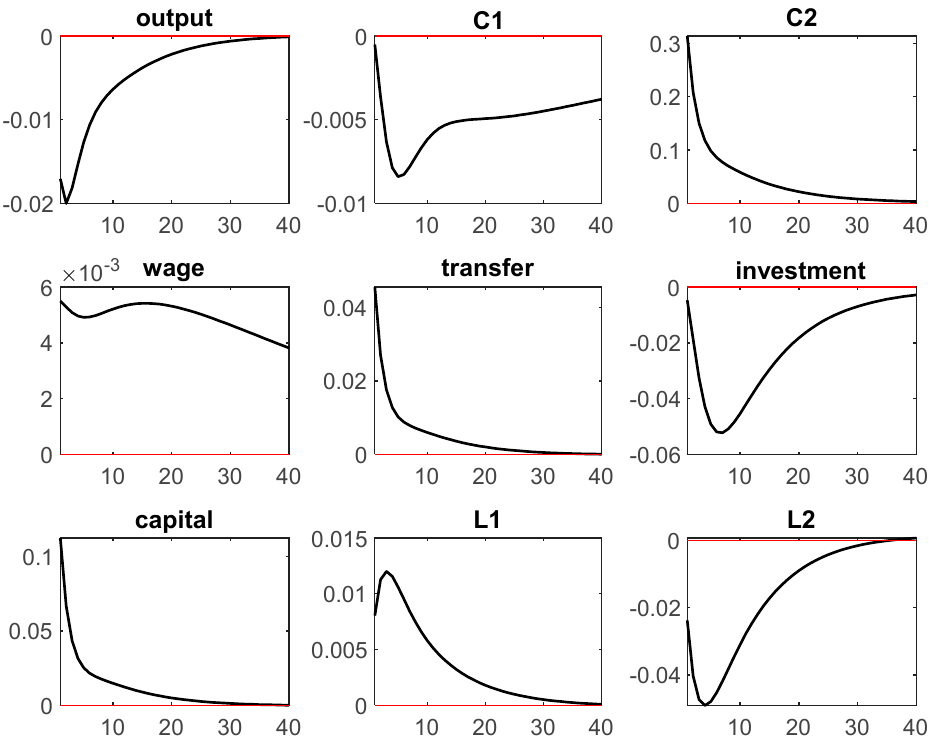
Figure 4. The results of the robustness test.